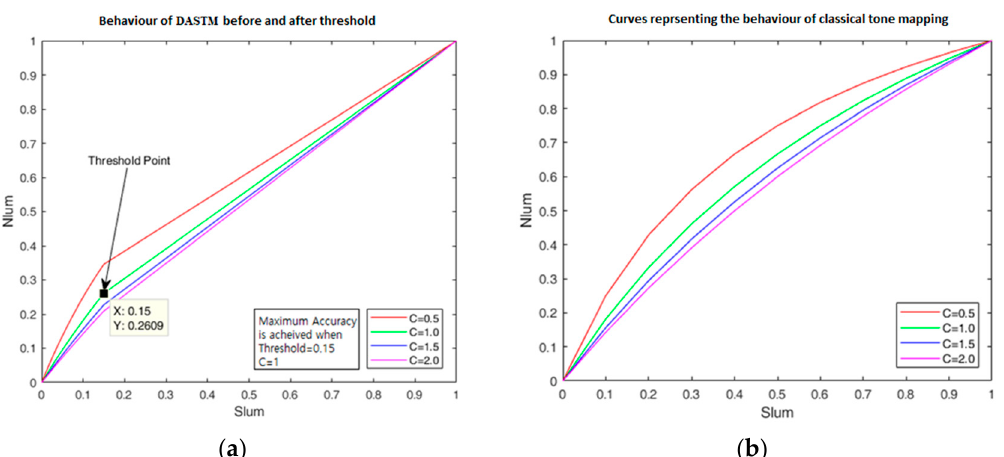
Figure 5. Graphical representation of new-scaled luminance: ( a ) new DASTM; and ( b ) classical tone mapping.